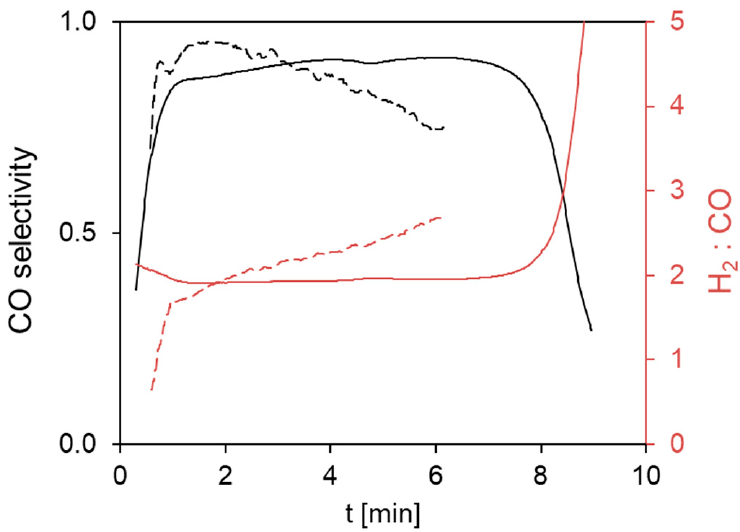
Figure 13. CO selectivity and H 2 :CO ratio in fixed-bed conditions at 1000 °C (dashed line) and fluidized-bed conditions at 970 °C (continuous line).